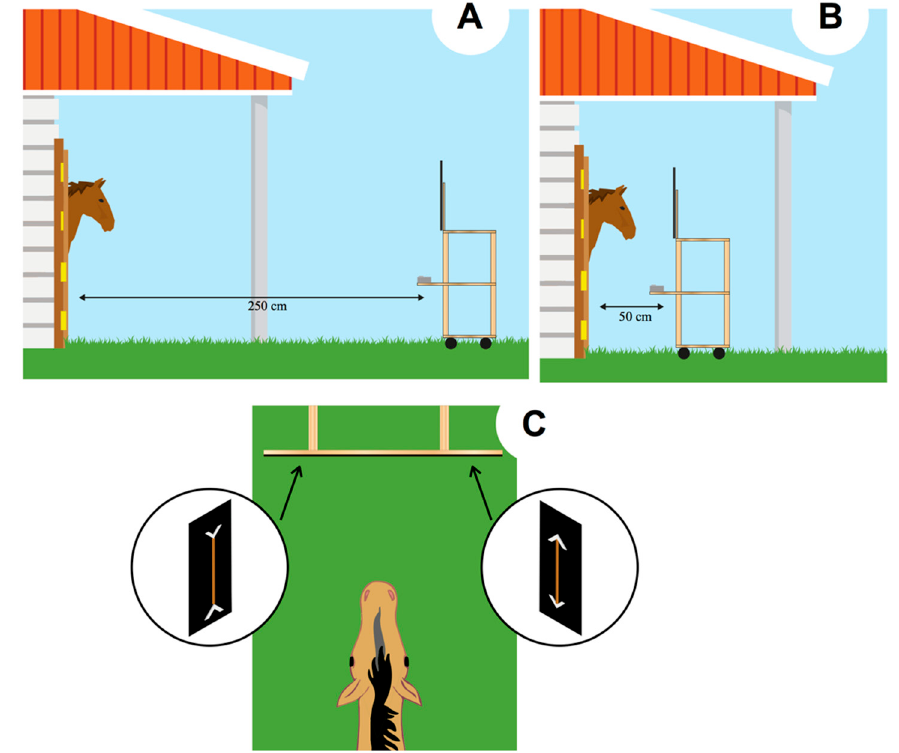
Figure 2. Experimental procedure. The tray was initially placed at a distance of 2.5 m ( A ). Then, the tray was pushed from behind toward the subject until it reached a distance of 50 cm ( B ). The horses were free to select one of the two display boards, by eating one of the two carrots ( C ).